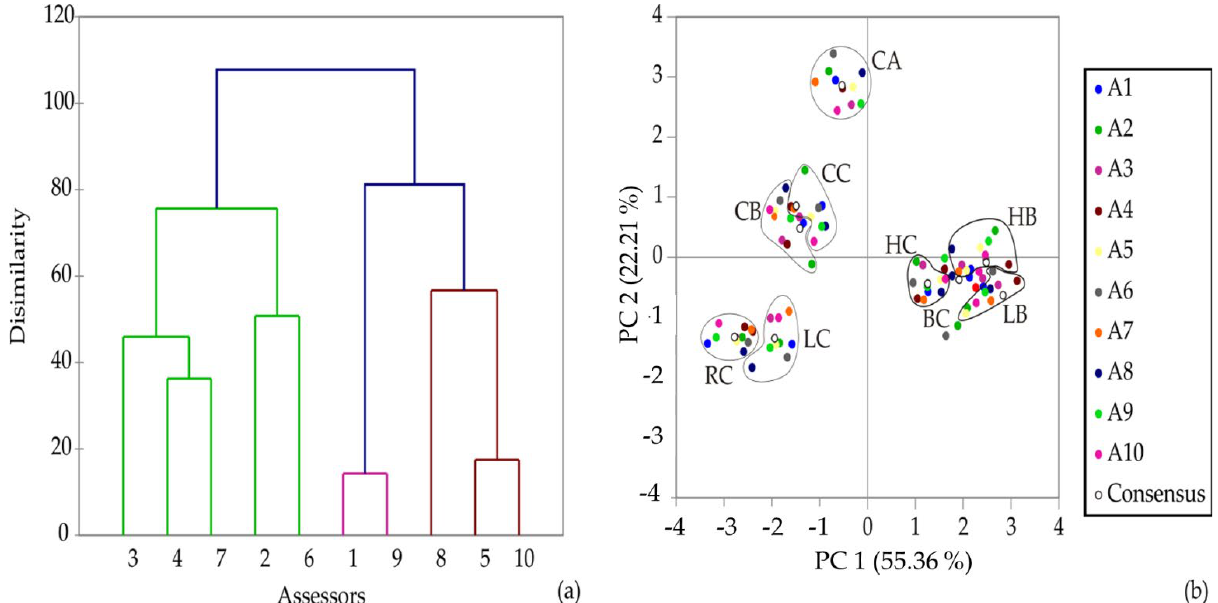
Figure 3. Multivariate analysis to discriminate the assessors’ sensory scores of products evaluated by sensory descriptors: ( a ) hierarchical clustering of the panel analysis and ( b ) PCA ordination of the GPA results.